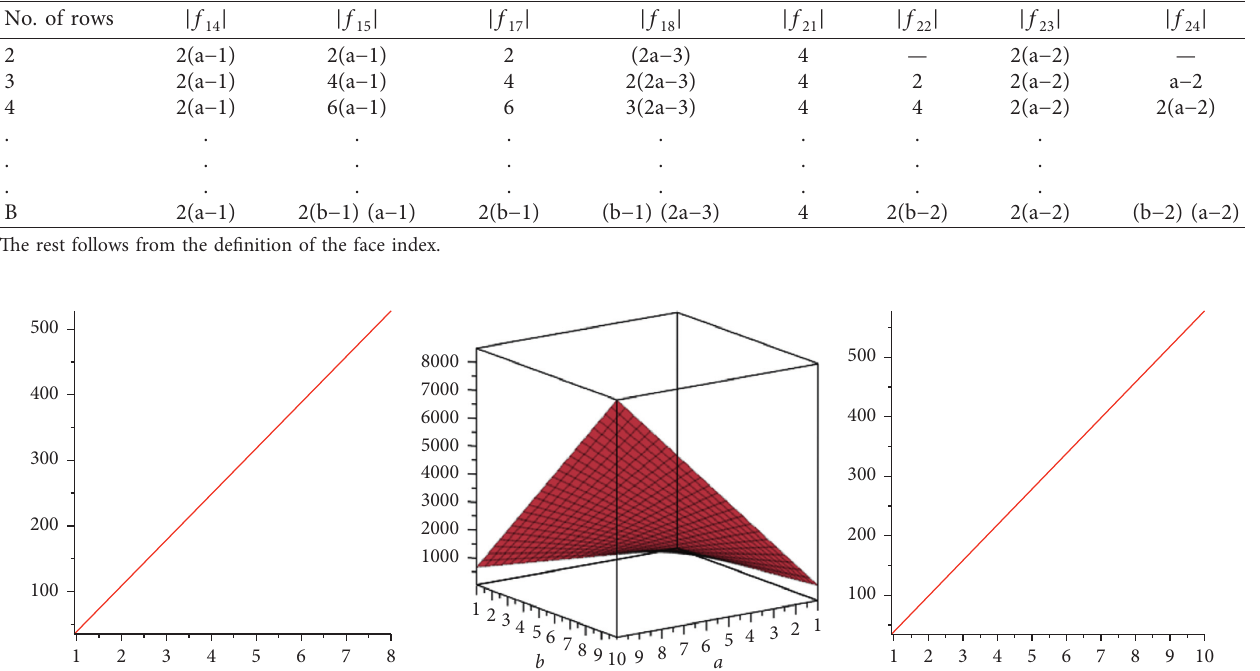
, f , f , f , f , f , f , and f 14 15 17 18 21 22 23